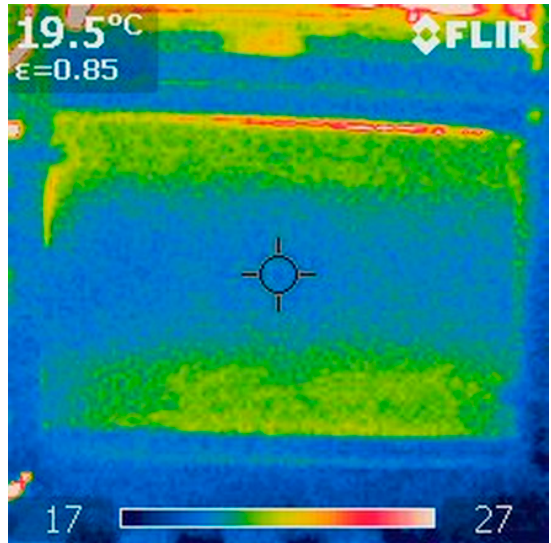
Figure 2. Hot box test of a panel. The blue area in the centre is the vacuum insulation, surrounded by the green area of the polymer foam